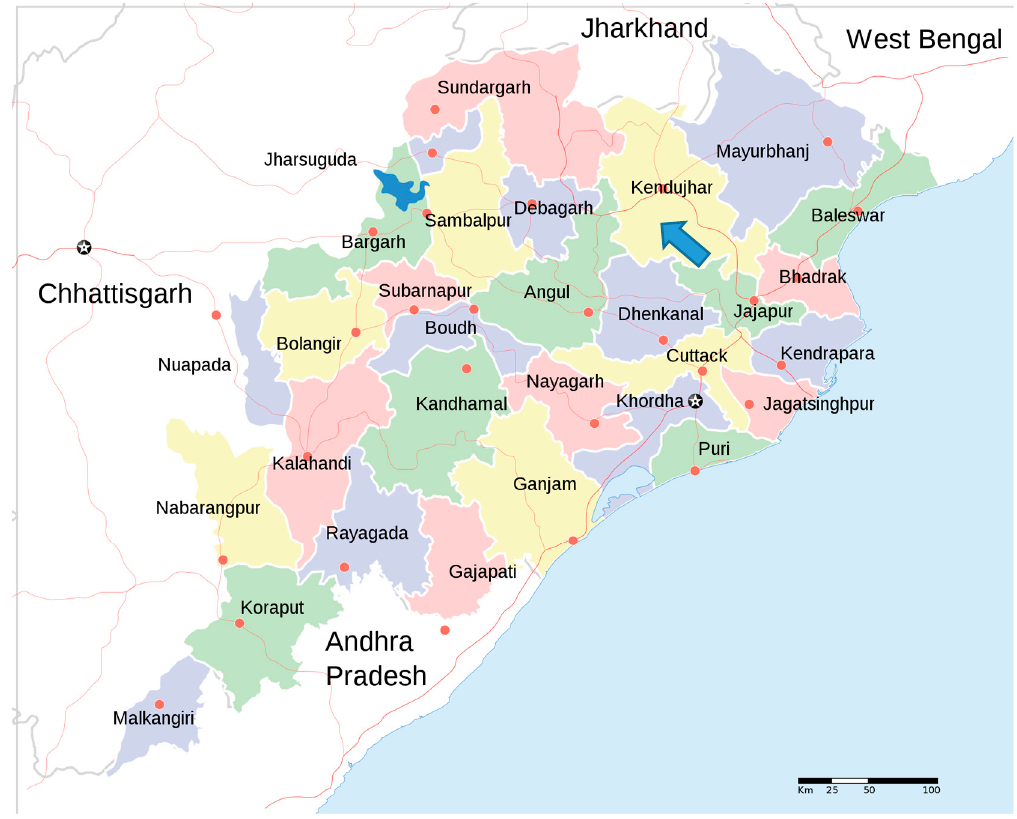
Figure 1. Keonjhar, Odisha, India: location of study sites. Source: https://commons.wikimedia.org/ wiki/File:Odisha_State_map.svg.